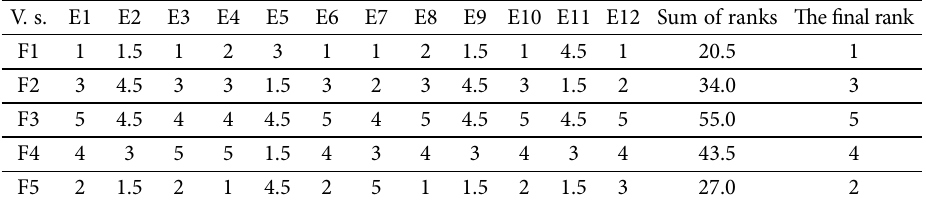
Table 7. Ranking factors in the group of the competence of technology developers regarding the commercial potential of technologies